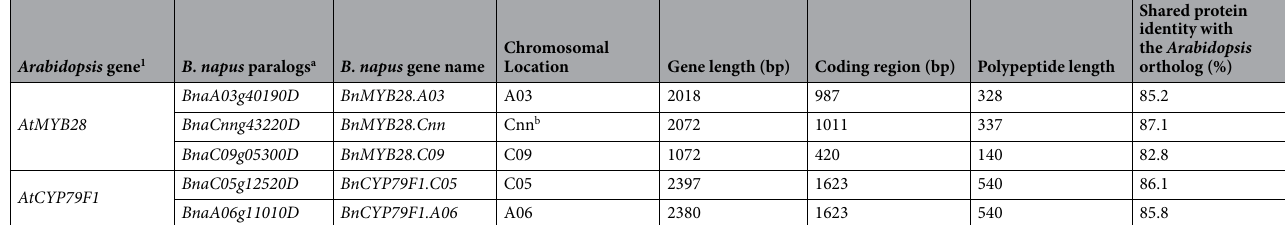
Table 1. Features of BnMYB28 and BnCYP79F1 paralogs with homology to the Arabidopsis genes AtMYB28 (AT5G61420) and AtCYP79F1 (AT1G16410) in oilseed rape. 1 A. thaliana gene sequences were retrieved from The Arabidopsis Information Resource (TAIR). a Sequence analysis of orthologs and paralogs in oilseed rape are based on gene models described in the Darmor- bzh reference genome (Genoscope). b Not anchored to a specific B. napus